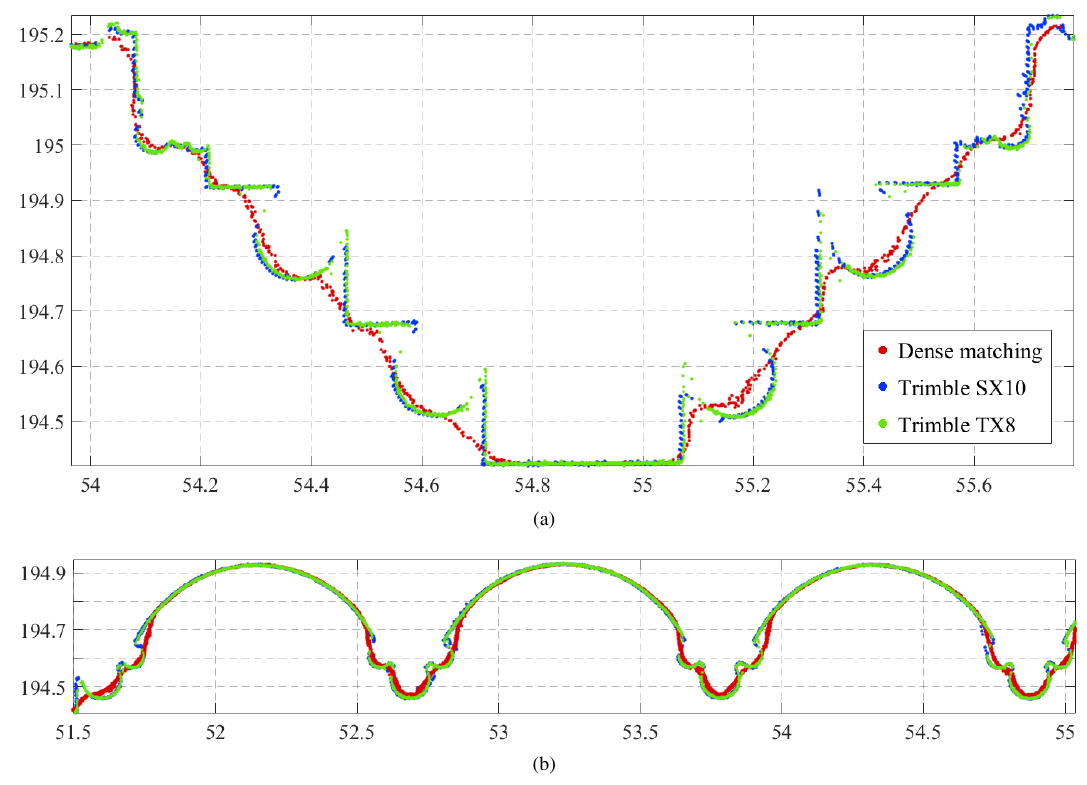
Figure 8. (a) Cross-sections located on the carved decor between gates and performed in Trimble SX10 point cloud (in blue) and in dense matching point cloud from Photoscan (in red). Reference section (in green) is issued from TX8 laser scanner point cloud. (b) Cross-sections performed in the same point clouds and located on the pillars above tympana. Scales are in